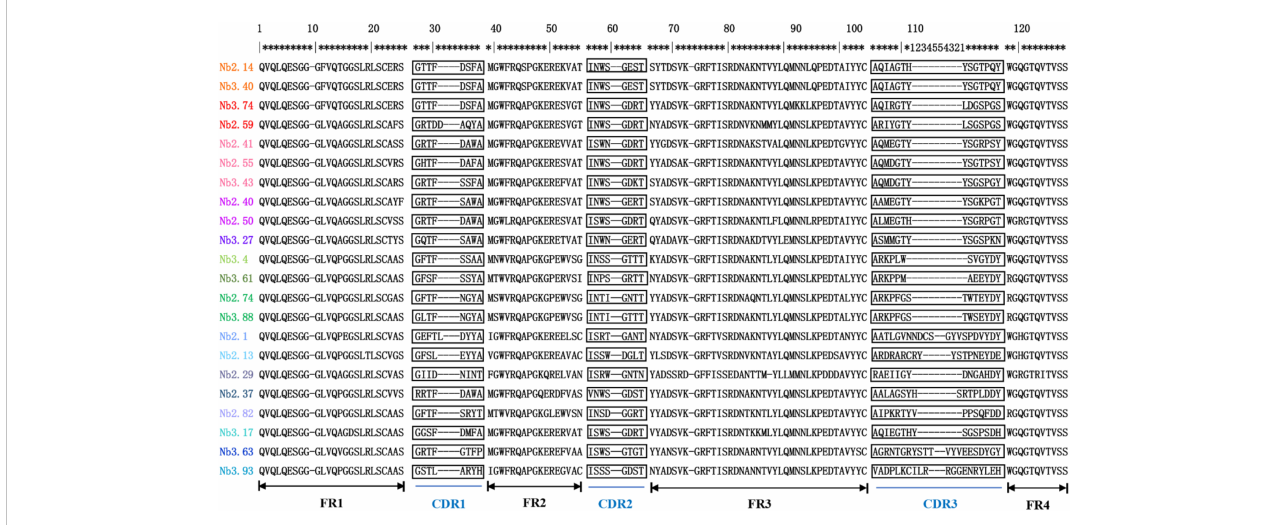
FIGURE 2 The amino acid sequence of BFT1 nanobodies. Framework regions (FR) and complementarities determining regions (CDR) were determined by blasting against the IMGT database. CDR sequences are marked with black rectangles, the same group is marked with the same